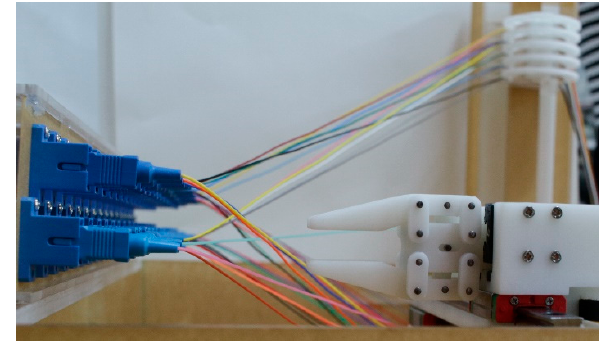
Figure 21. Double-port shed diagram.